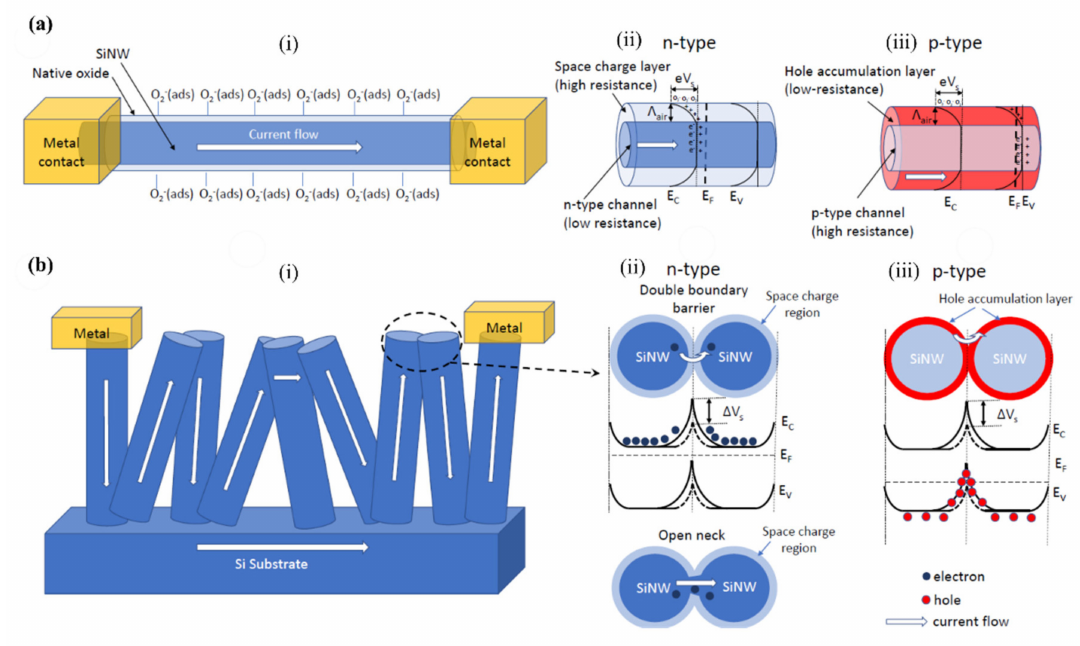
Figure 5. Schematic of ( a )i a separate horizontal SiNW and ( a )ii and ( a )iii show conduction path in n-type (which is through inner part of SiNW) and p-type (which is through outer shell of SiNW) respectively. ( b )i multiple vertical SiNWs with NW / NW junction barriers shown in ( b )ii for n-type and ( b )iii for